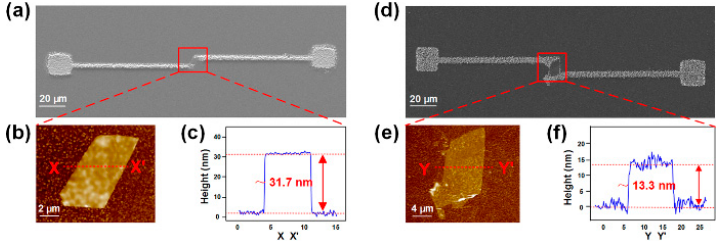
Figure 13. SEM images of MoS 2 thin-film transistors fabricated with Au ( a ) and Ag ( d ) electrodes; ( b , e ) are the enlarged view of the rectangle areas in ( a , d ), respectively; ( c , f ) are the AFM characterization results of the heights of MoS 2 thin-film transistors (reproduced from Ref. [78]).